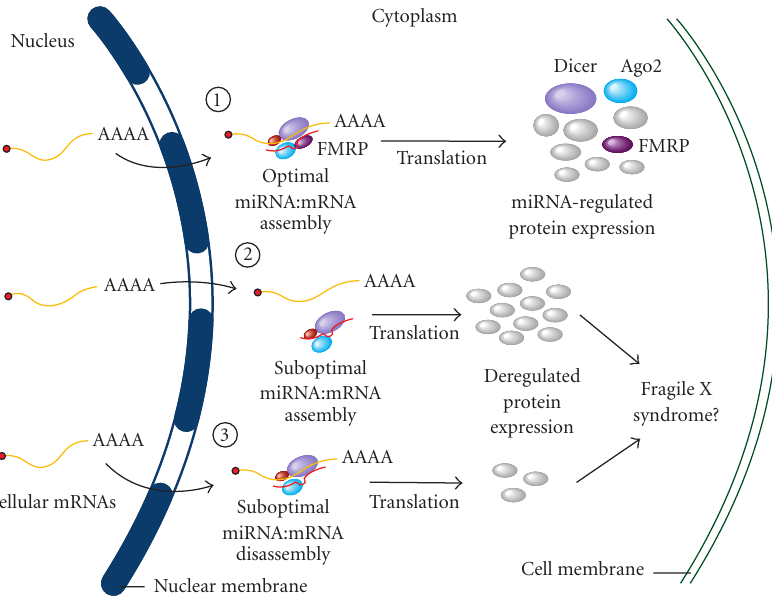
Figure 3: A potential role for suboptimal miRNA:mRNA assembly and/or disassembly in the etiology of the fragile X syndrome. (1) miRNA assembly on target mRNAs may be optimal when facilitated by FMRP, which may also be required for optimal relief of miRNA-guided translational repression. (2) In the absence of FMRP, suboptimal miRNA assembly on target mRNAs may lead to overexpression of specific proteins. (3) Whereas suboptimal disassembly of FMRP-deficient miRNPs from target mRNAs may result in a prolonged inhibition of trans- lation. The resulting misbalanced expression of miRNA-regulated genes may alter downstream cellular processes and metabolic pathways (not depicted in this figure) and lead to the development of the fragile X